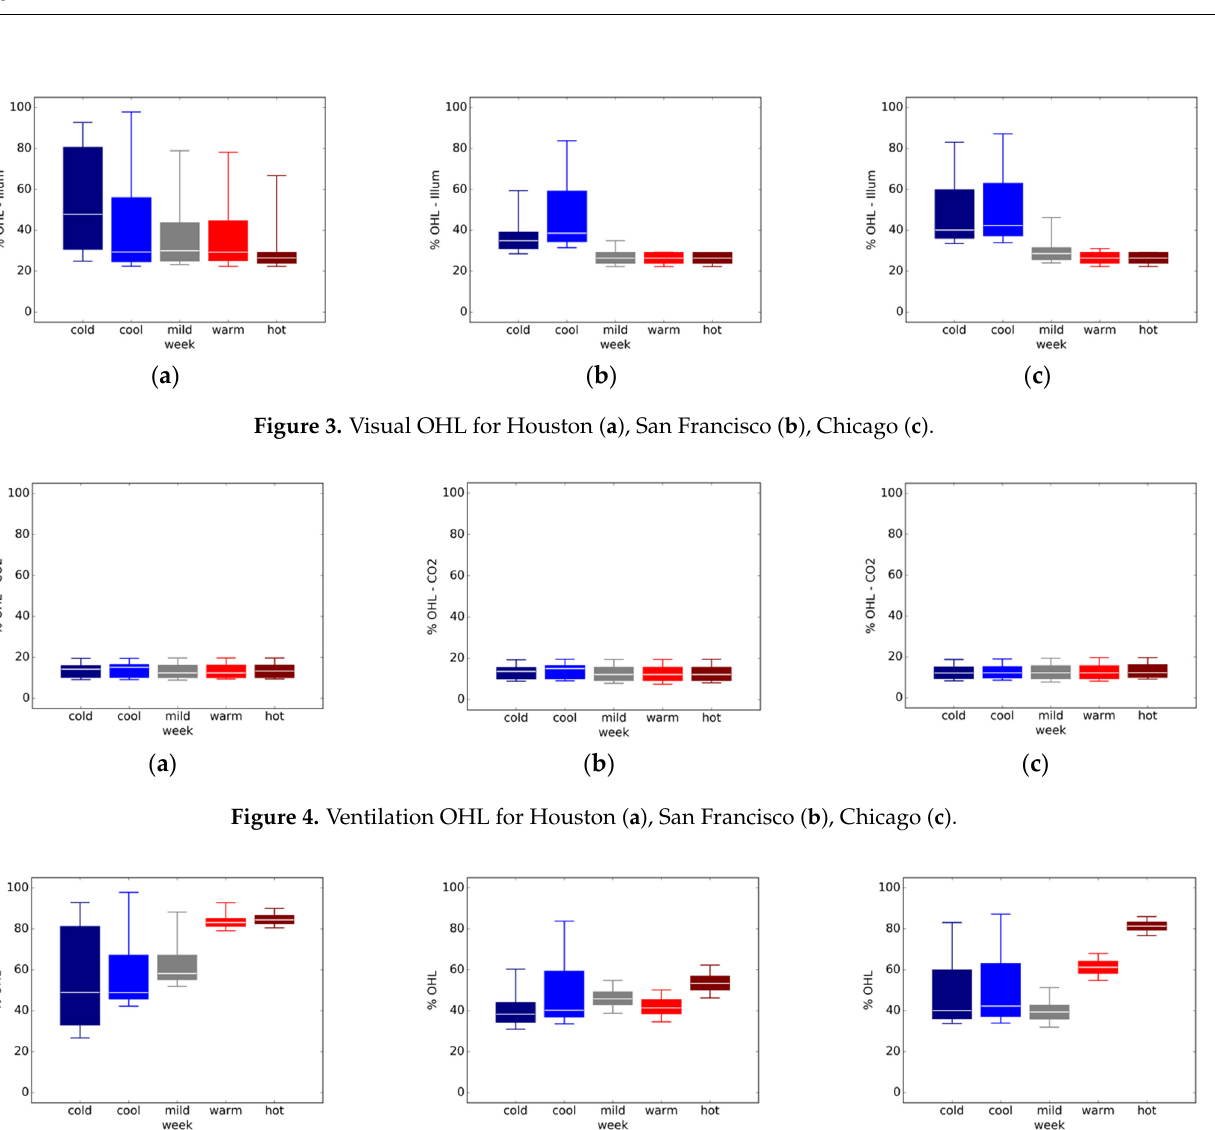
Figure 2. Thermal OHL for Houston ( a ), San Francisco ( b ), Chicago ( c ).